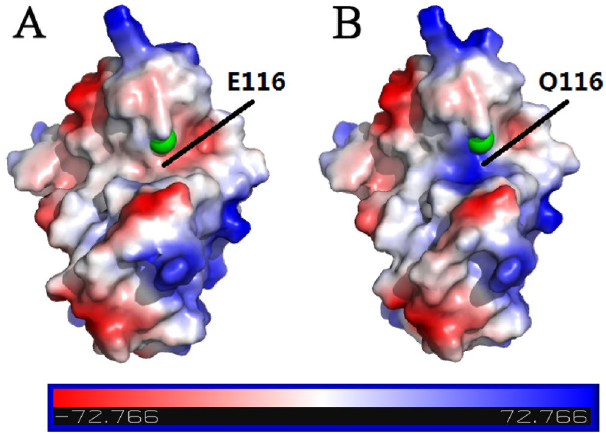
Figure 2. Electronic surface potential comparison between ( A ) native ScWss1 21-148 (PDB: 5XBN) and ( B ) its mutant ScWss1 116E-Q (24-149) (PDB: